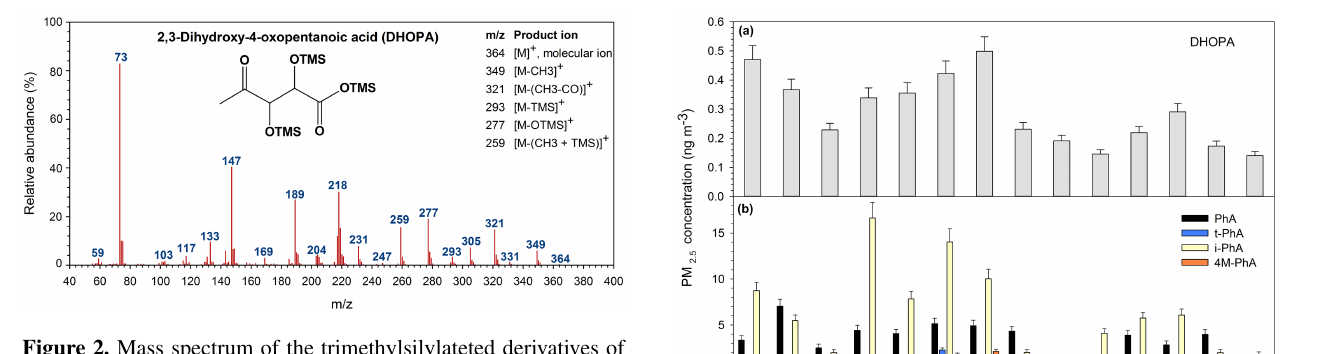
Figure 2. Mass spectrum of the trimethylsilylateted derivatives of 2,3-dihydroxy-4-oxopentanoic acid by electron impact ionization.